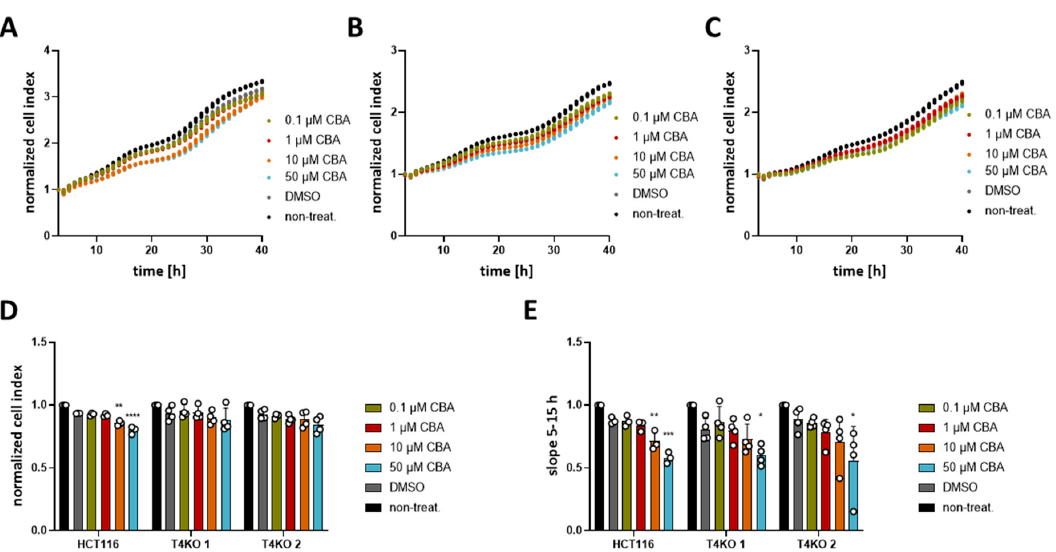
Figure 3. Effect of CBA on HCT116 cells’ proliferation. Cell proliferation was determined with an xCELLigence ® system. Cells were treated with 0.1 µ M, 1 µ M, 10 µ M, 50 µ M CBA, or DMSO control. A total of 3–4 independent experiments were performed. ( A ) Mean of cell index was plotted versus time for HCT116 cells. ( B ) Same as ( A ) for T4KO 1 cells. ( C ) Same as ( A ) for T4KO 2 cells. ( D ) Scatter plot and bar diagram of data (mean + SD) at 24 h from the experiment in ( A – C ). ( E ) Scatter plot and bar diagram of slope steepness between 5 and 15 h (mean + SD) from data in ( A – C ). One-way ANOVA was used to determine statistical significance (* p < 0.05, ** p < 0.005, *** p < 0.0005, **** p < 0.0001) in ( D , E ).